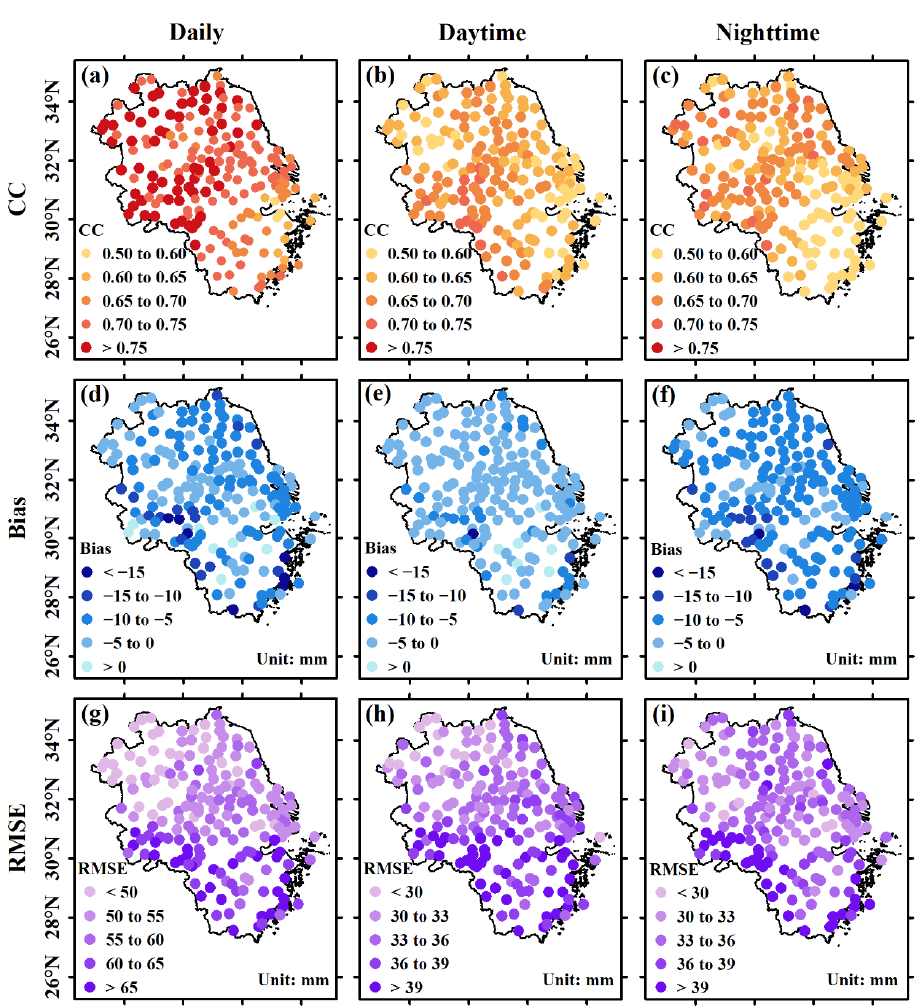
Figure 7. Correlation coefficient ( CC ) ( a – c ), Bias ( d – f ), and RMSE ( g – i ) between the monthly time series of precipitation amount data of stations and their corresponding ERA5 grid points at the daily, daytime, and nighttime scales (left, middle, and right panels, respectively) for the period 1961–2018 in the YRD.